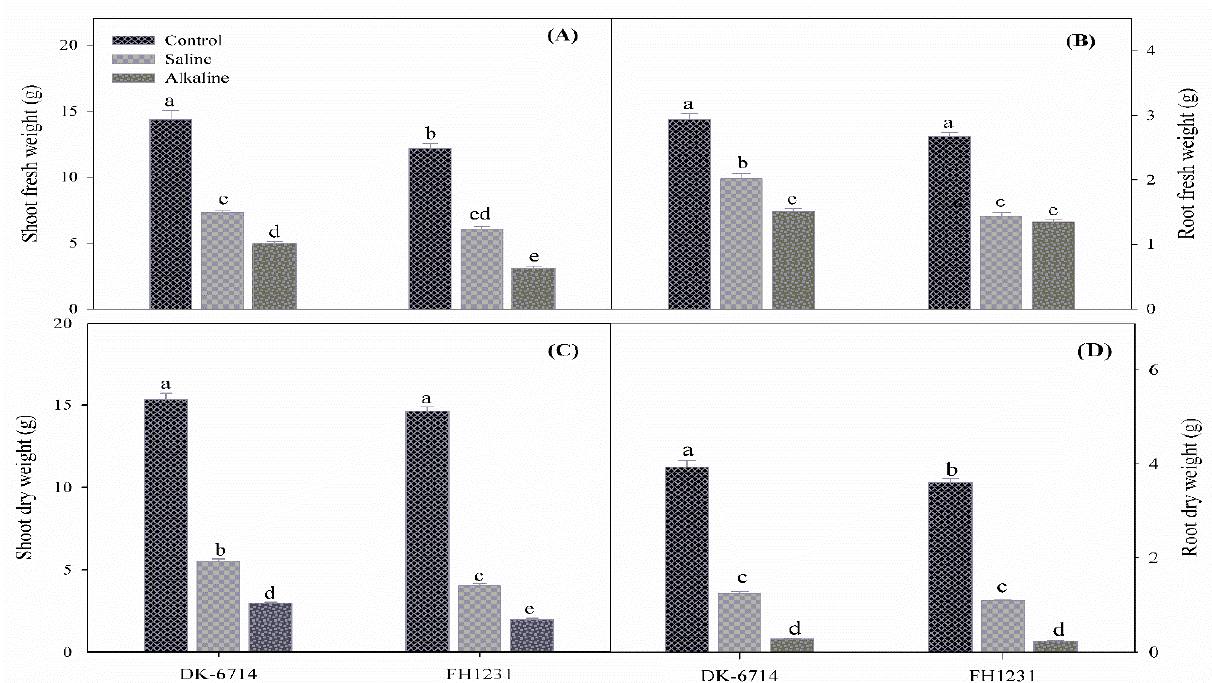
Figure 1. Effect of salinity and alkalinity stress on ( A ) shoot fresh weight, ( B ) root fresh weight, ( C ) shoot dry weight, and ( D ) root dry weight of 20-day-old maize hybrids (DK-6714 and FH-1231). The bars represent the standard error (±SE) of the four replicates. Similar small letters above bars represent nonsignificant (ns) differences among treatments ( p ≤ 0.05).